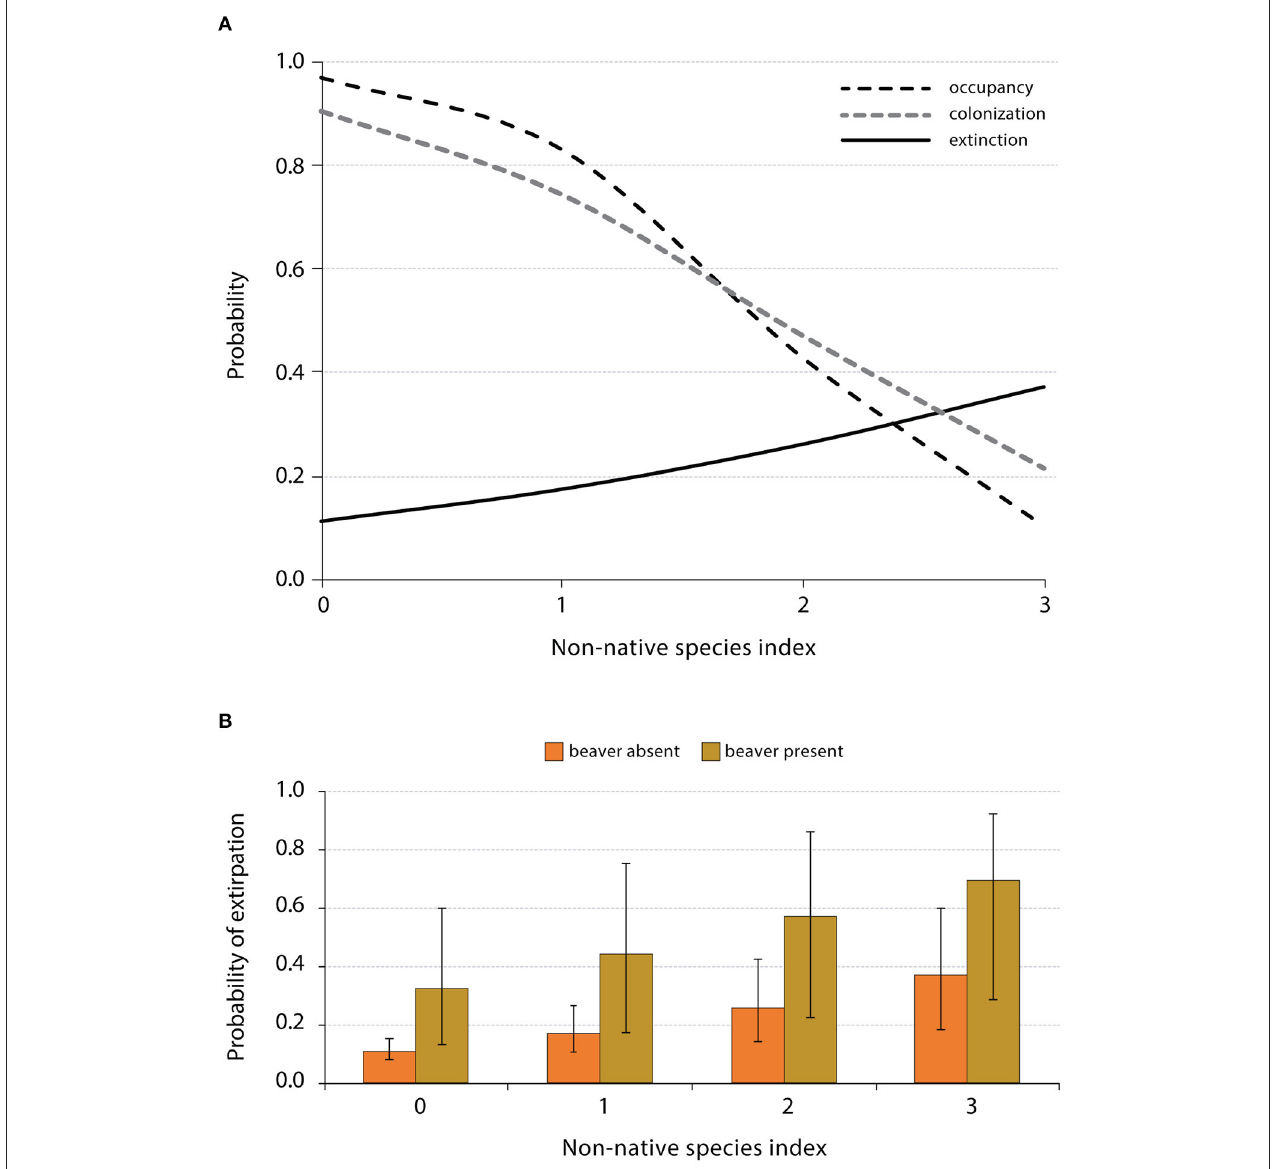
FIGURE 2 | (A) Effect of the non-native aquatic species index [i.e., number of non-native species observed at a site, either American bullfrog, red swamp crayfish, or large predatory fish (e.g., Micropterus sp.)] on the probability of occupancy, colonization, and local extinction of arroyo toad in coastal San Diego county from 2003 to 2018. (B) Probability of extirpation for arroyo toad at a given site (250m scale) in relation to the presence of non-native aquatic species (i.e., the non-native aquatic species index) and